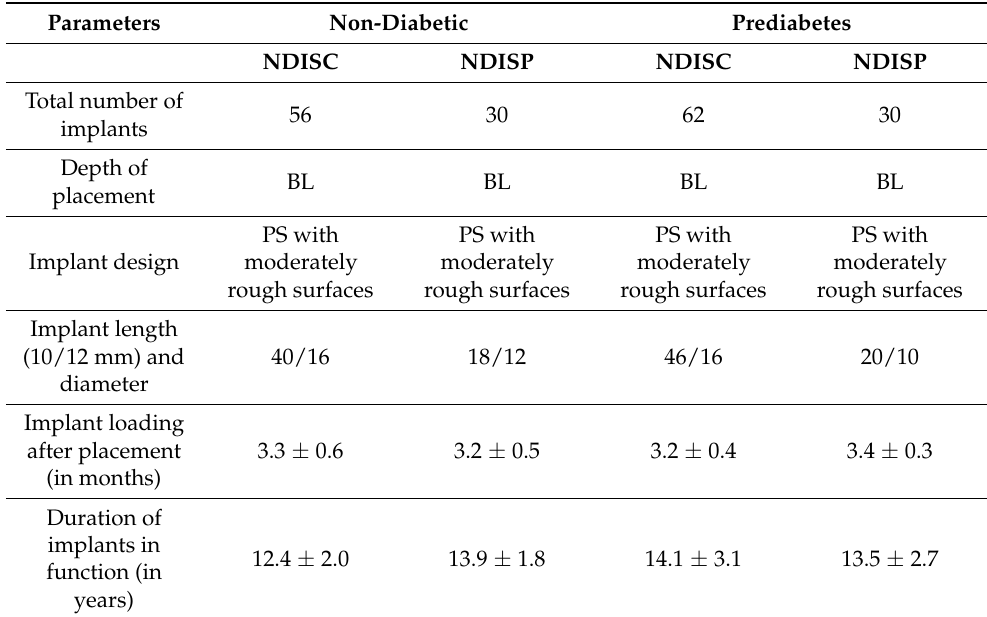
Table 2. Implant-related